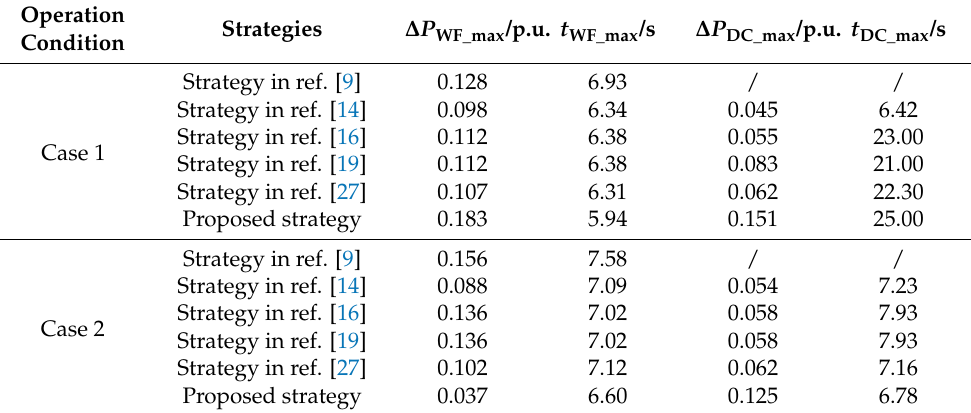
Table 10. Frequency response output of different control strategies based on the operating conditions of Case 1 and Case